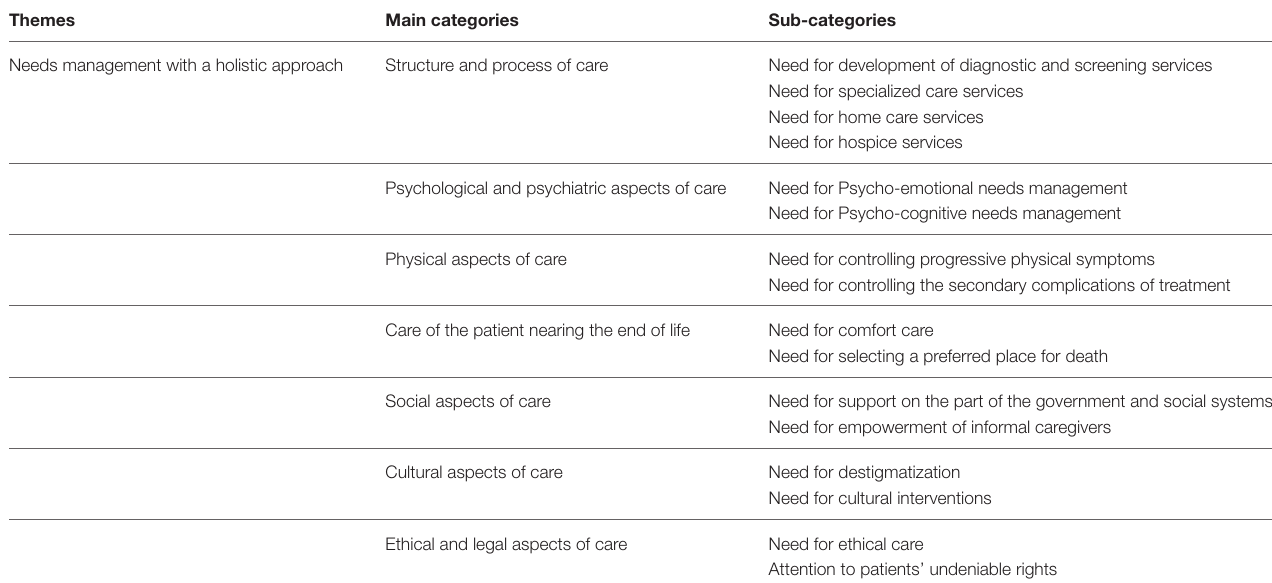
TABLE 4 | Themes, main categories, and sub-categories resulting from the content-driven analysis of the